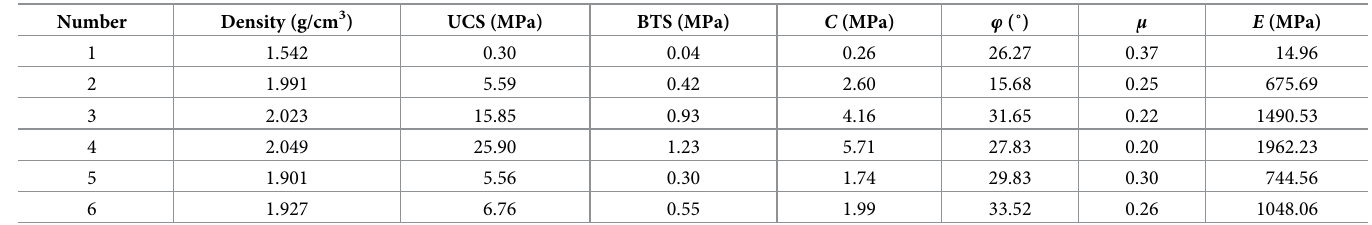
Table 2. Test results of physical and mechanical properties of concrete